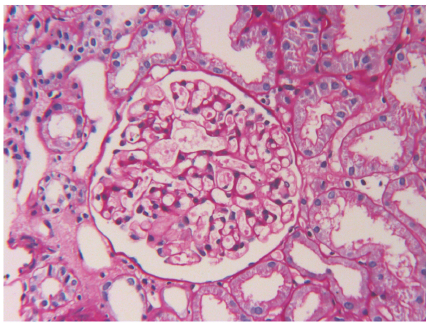
Figure 2: Photomicrograph from renal biopsy showing an unre- markable appearing glomerulus (PAS X 200).